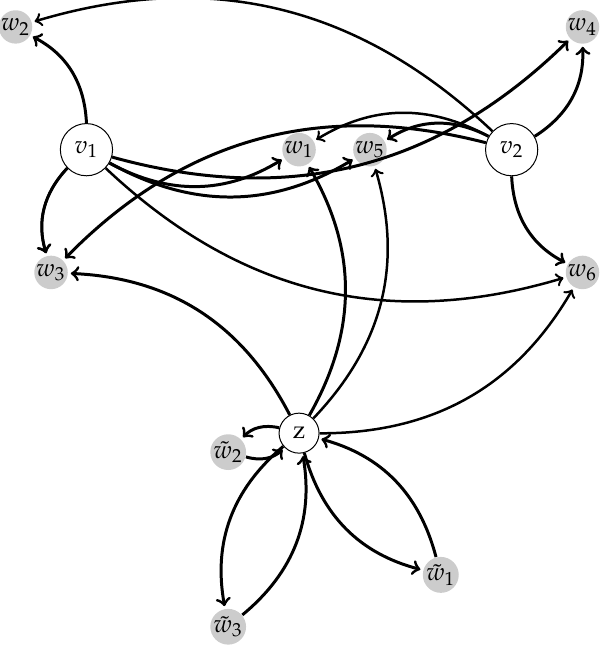
Figure 2. Modular architecture. This can be seen as an example of the architecture described in [6]. The switching module consists of the center z and the satellites ˜ w 1 , ˜ w 2 , ˜ w 3 . The generating module consists of the centers v 1 , v 2 and the satellites w 1 , . . . , w 6 . Note that there is a feedback between z and the satellites w i ; however, there is no feedback of w j on v l